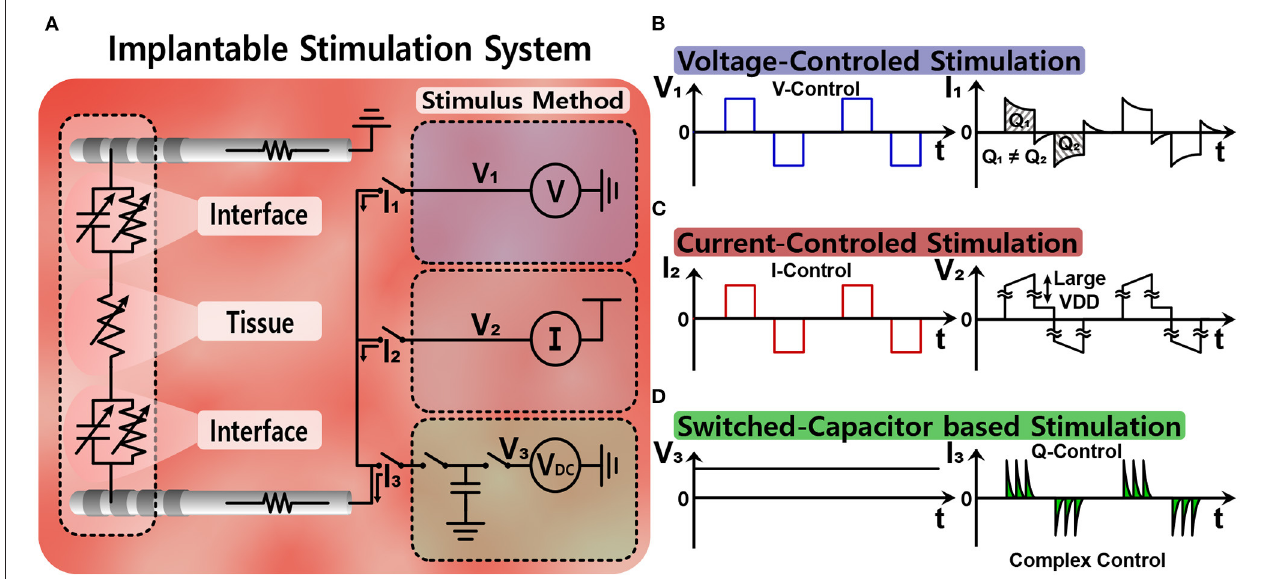
FIGURE 5 | Simple equivalent circuit models of various stimulation methods: (A) equivalent circuit models for stimulation, (B) voltage-controlled stimulation, (C) current-controlled stimulation, and (D) switched-capacitor based stimulation.